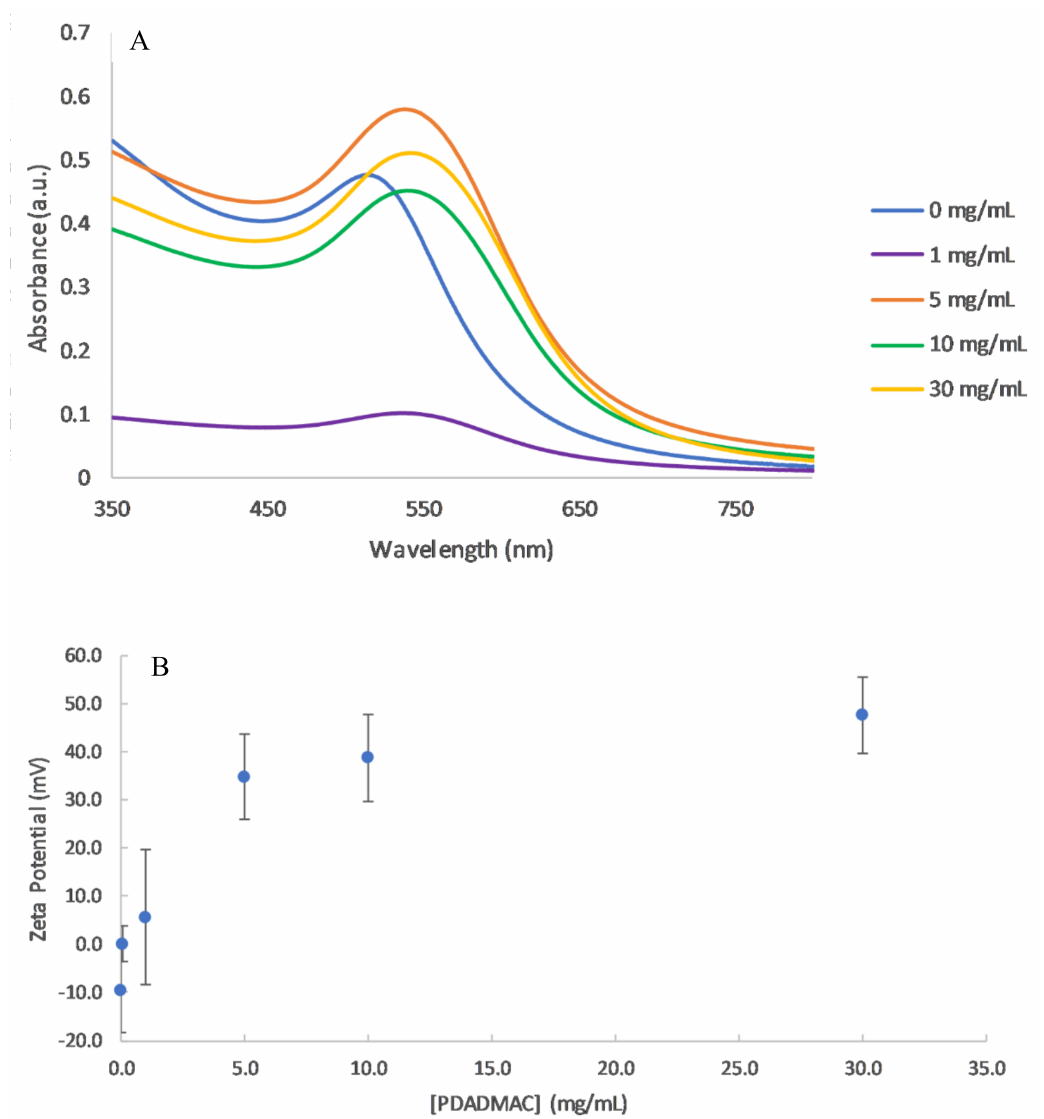
Figure 2. ( A ) UV–vis spectra of PDADMAC coated AuNP at concentrations of 0–30 mg/mL PDADMAC in 1 mM NaCl. ( B ) Zeta potential measurements as a function of PDADMAC concentration at pH